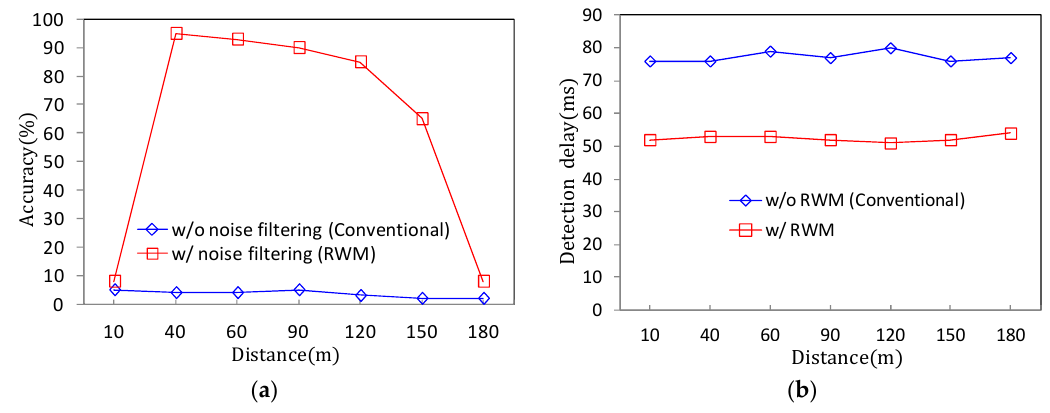
Figure 16. Vehicle detection accuracy and delay performance comparison: ( a ) Accuracy performance according to target distance; ( b ) delay performance according to target distance.